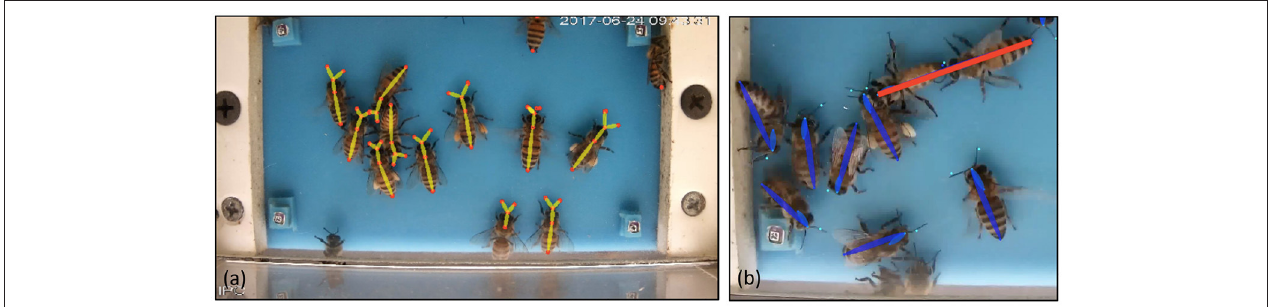
FIGURE 4 | Examples of bee skeletons reconstructed in the inference stage. (a) Because of the bottom-up greedy association, a partial skeleton can be generated even when some keypoints are not visible or detected. The use of our modified PAF score also enables the correct associations in crowded areas by constraining both orientation and length of the connections. (b) Example of incorrect association (in red) between head and abdomen obtained if factor π j are aligned.